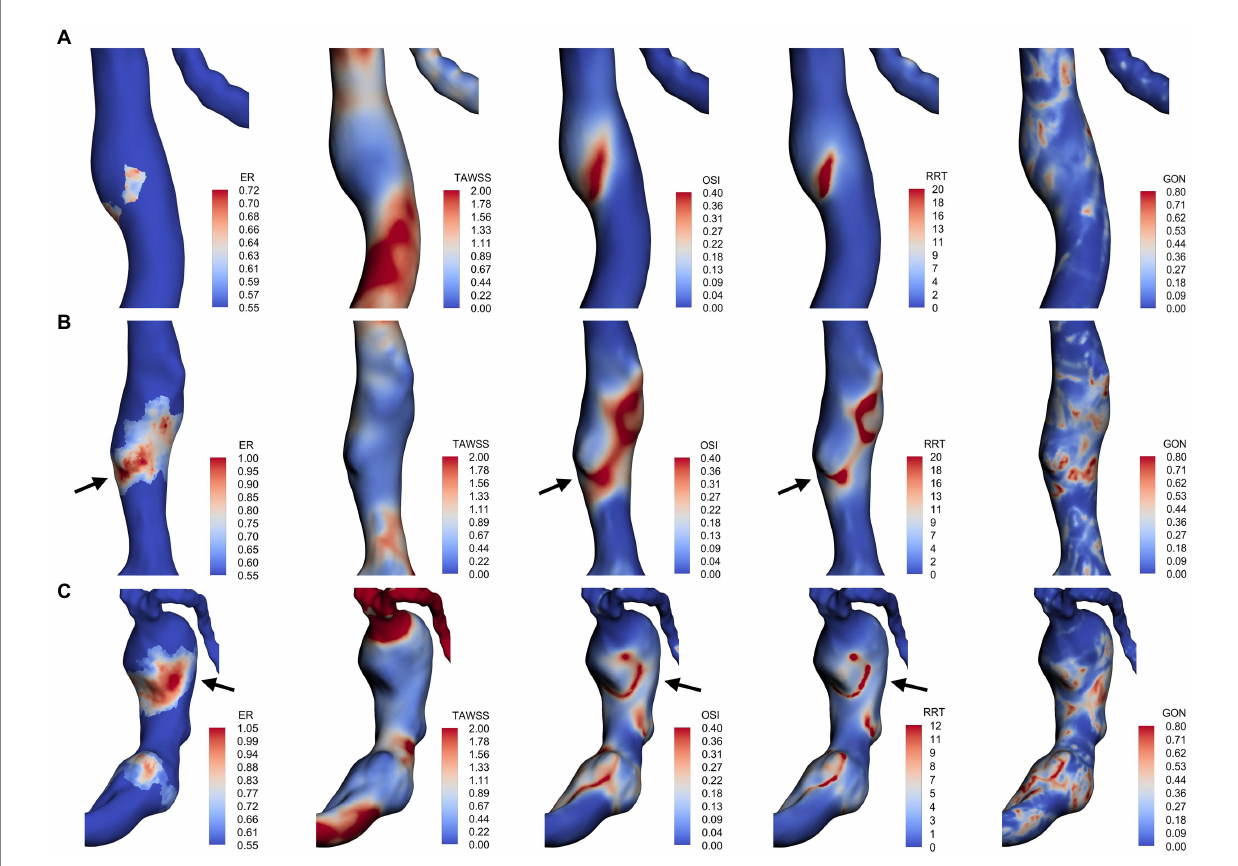
FIGURE 3 AWE distribution and hemodynamic characteristics of fusiform type (A) , dolichoectatic type (B) , and transitional type (C) . AWE was found in areas with low TAWSS in all three types. Some locations with higher AWE showed higher OSI and RRT (black